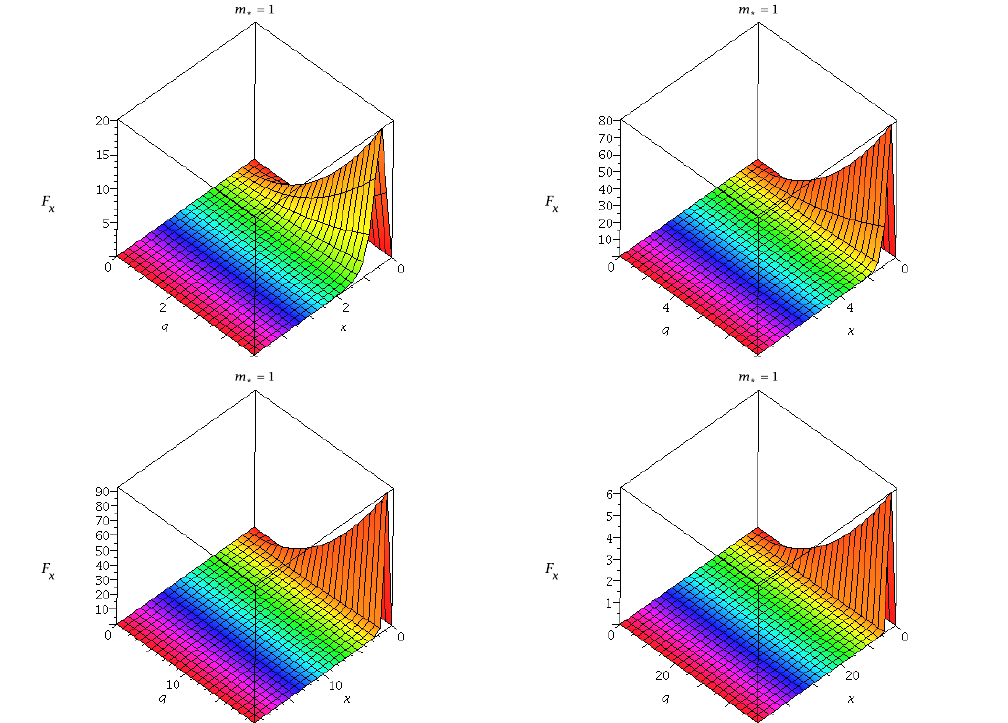
Figure 6. The figure depicts the variation of F x with x and q for ABG